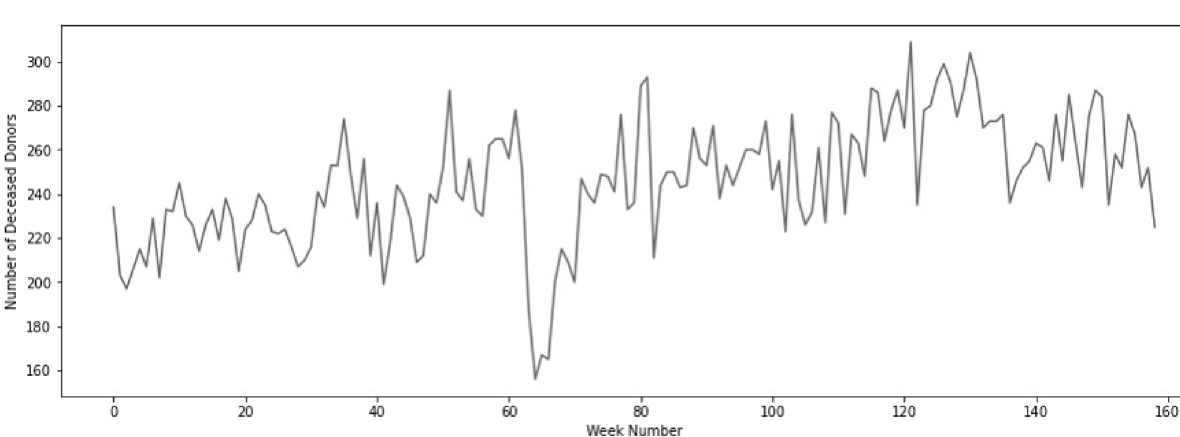
Figure 1. Total number of USA deceased organ donors per year, 1988–2021.